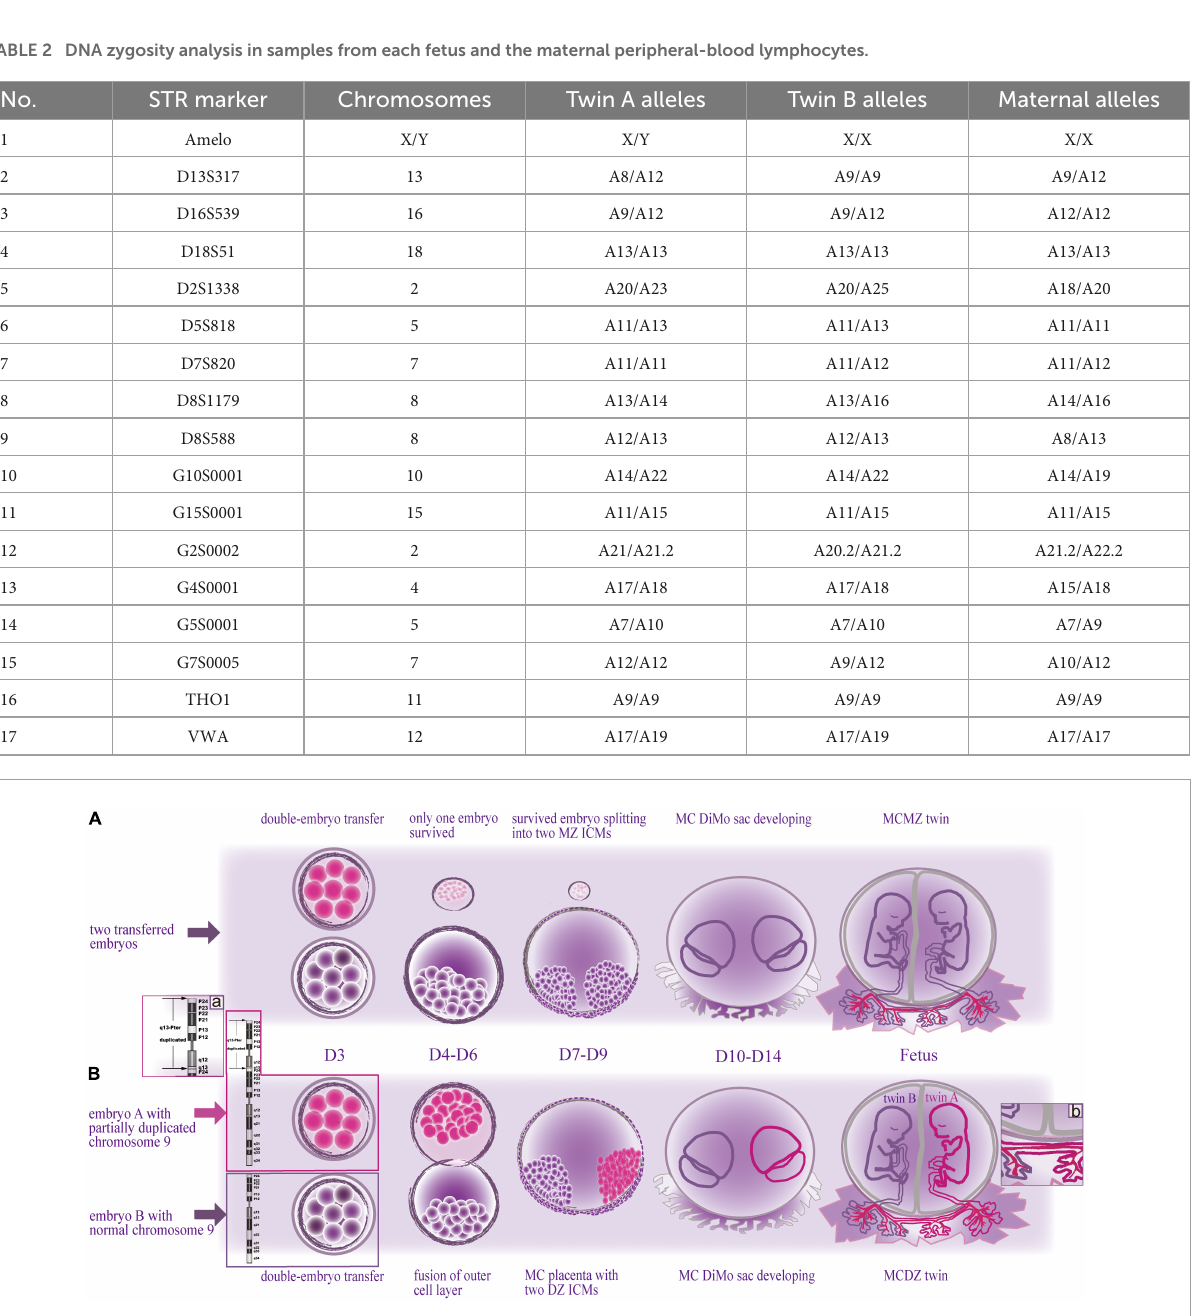
FIGURE3 Schematic drawing of two types of embryonic development with monochorionic diamniotic twins after double-embryo transfer. (Above) The formation of monochorionic monozygotic twins in common cases. (Below) The formation of monochorionic dizygotic twins in this case. MZ, monozygotic; MC, monochorionic; DZ, dizygotic; DiMo, diamniotic; ICM, inner cell mass; D, day. (A) Enlarged view illustrates the cause of death of twin A, the duplicated segment of chromosome 9; (B) enlarged view illustrates the cause of death of twin B, the vascular anastomoses between the